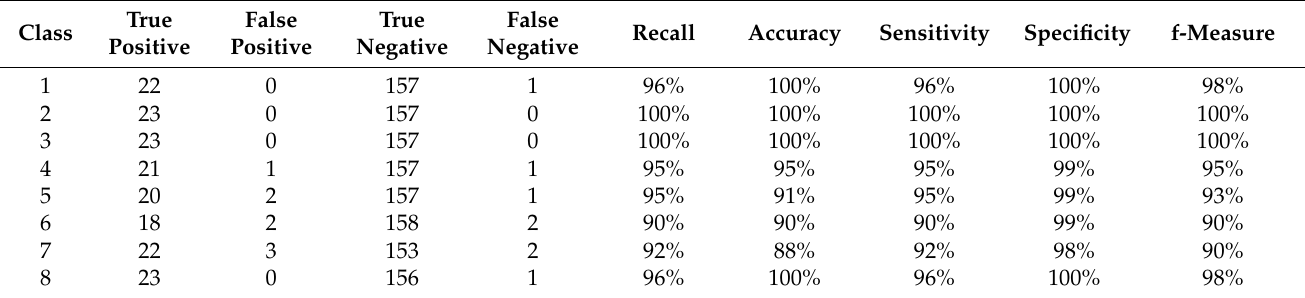
Table 5. Results of classification of eight investigated classes of PDs that applied Bayes classifier.